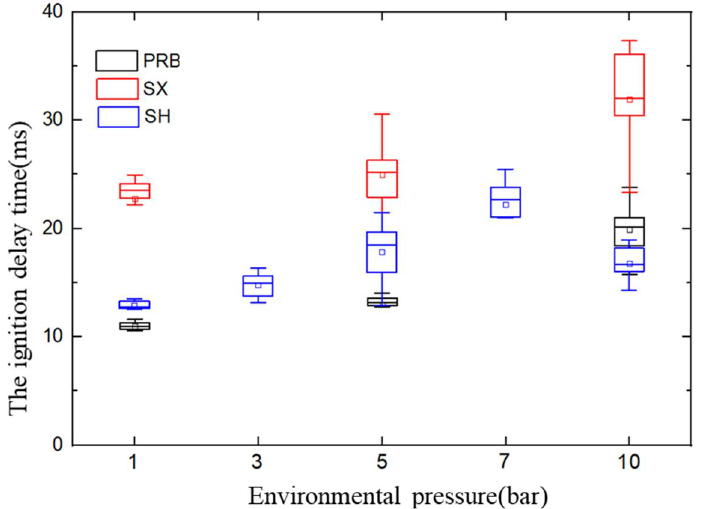
Figure 11. Box plot of the ignition delay time for three kinds of pulverized coal under different